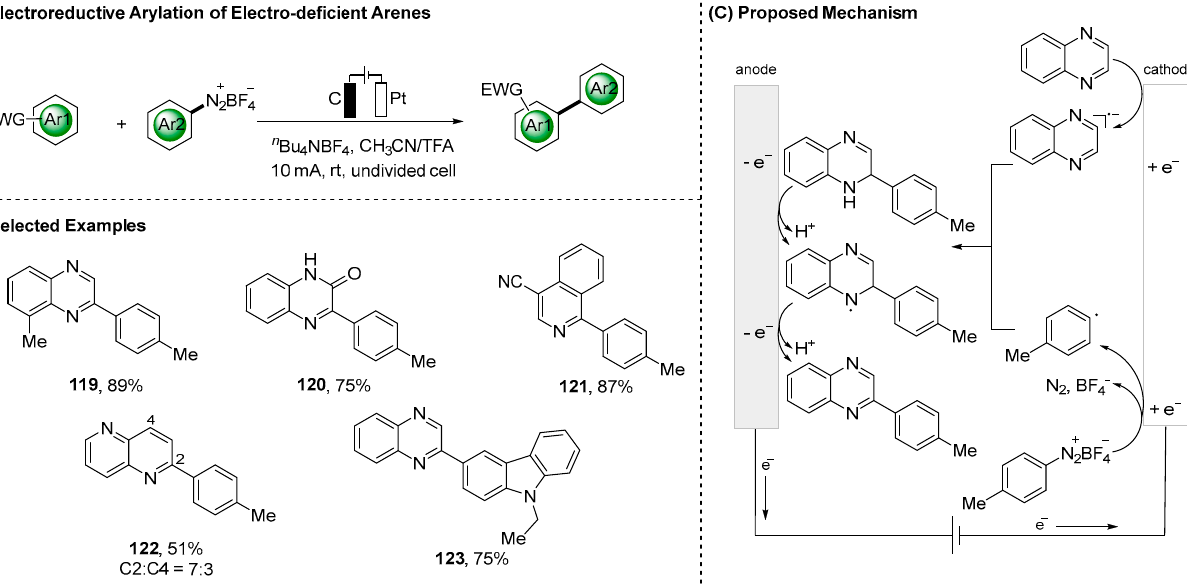
Figure 15. Direct electroreductive arylation of electro-deficient